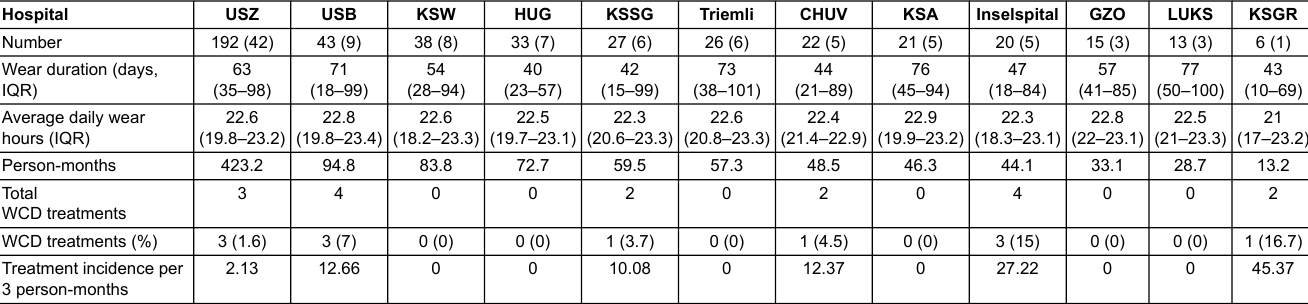
Table 2: Wearable cardioverter defibrillator (WCD) data for the study